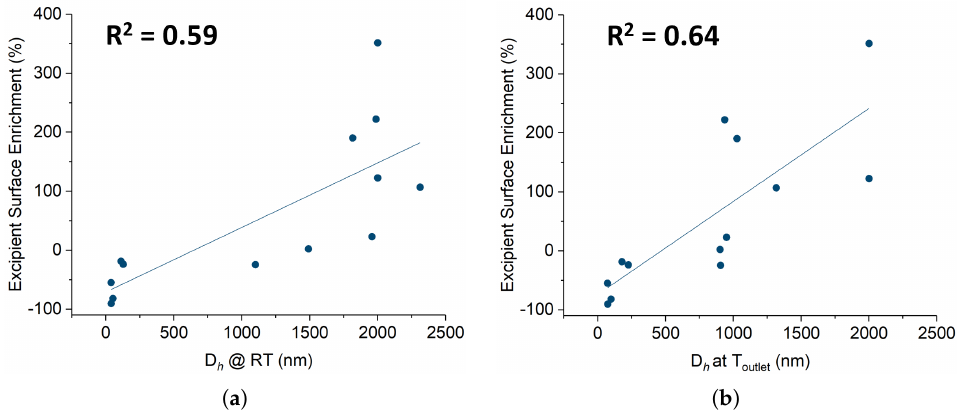
Figure 6. Preferential adsorption of excipient on particle surface increases with size. One sample (7-1[med-OH]) was statistically eliminated by the Grubbs outlier test [23]. Fit was improved when D h at T outlet (70 °C) was used to predict preferential surface adsorption of the excipient (R 2 = 0.59 vs. R 2 = 0.64). ( a ) Preferential surface adsorption vs. D h at RT (25 °C); ( b ) Preferential surface adsorption vs. D h at T outlet (70